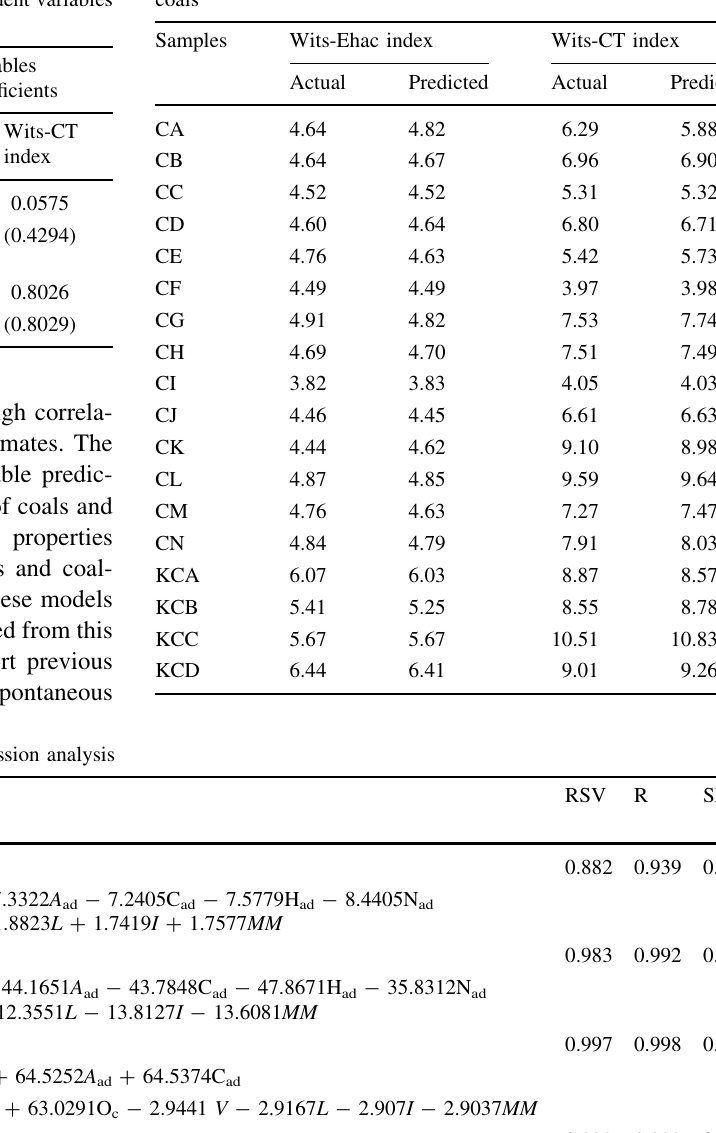
Table 9 Actual and predicted Wits-Ehac and Wits-CT index for